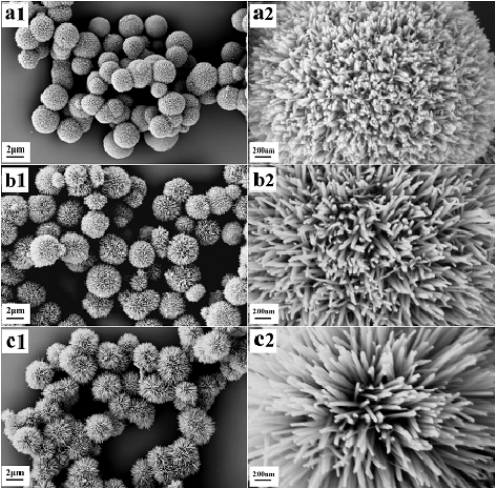
Figure 18. SEM images of MnO 2 ‐ 40 ( a 1, a 2), MnO 2 ‐ 60 ( b 1, b 2), and MnO 2 ‐ 80 ( c 1, c 2). Reprinted with permission from Ref. [40]. Copyright 2016 Elsevier.